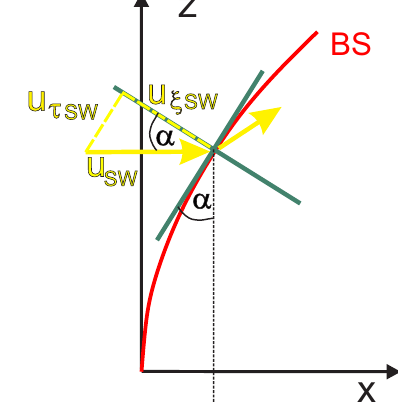
Fig. C1. Projection of the solar wind velocity vector with respect to curvilinear bow shock